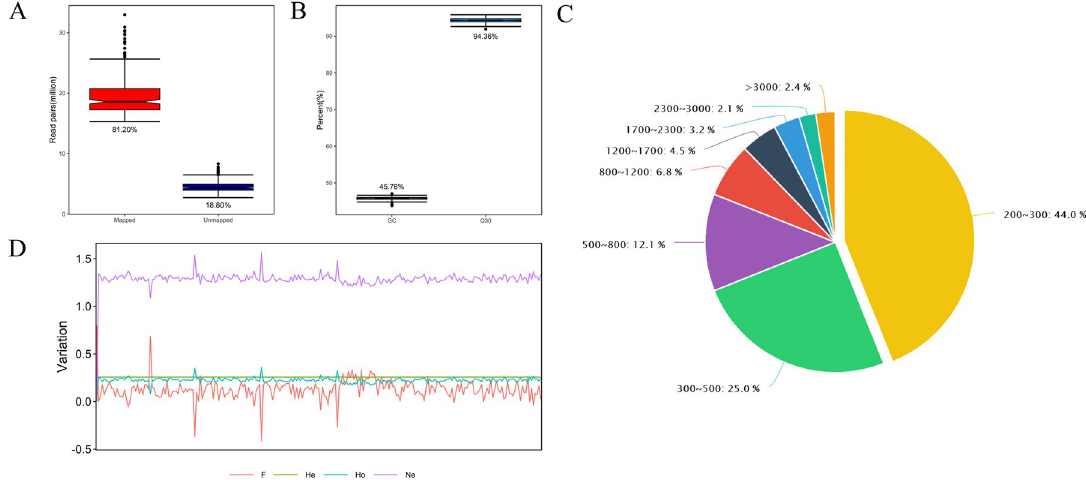
Fig 2. Transcriptome analysis of 240 selected slash pine trees. A Percentages of read pairs aligned to the reference sequence. B GC content and Q30 proportion. C The proportion of unigenes with different sequence lengths. D Transcript variation in the slash pine population ( F , H , H , N ). The vertical axis shows the proportion of each variation value relative to all values. is e o e